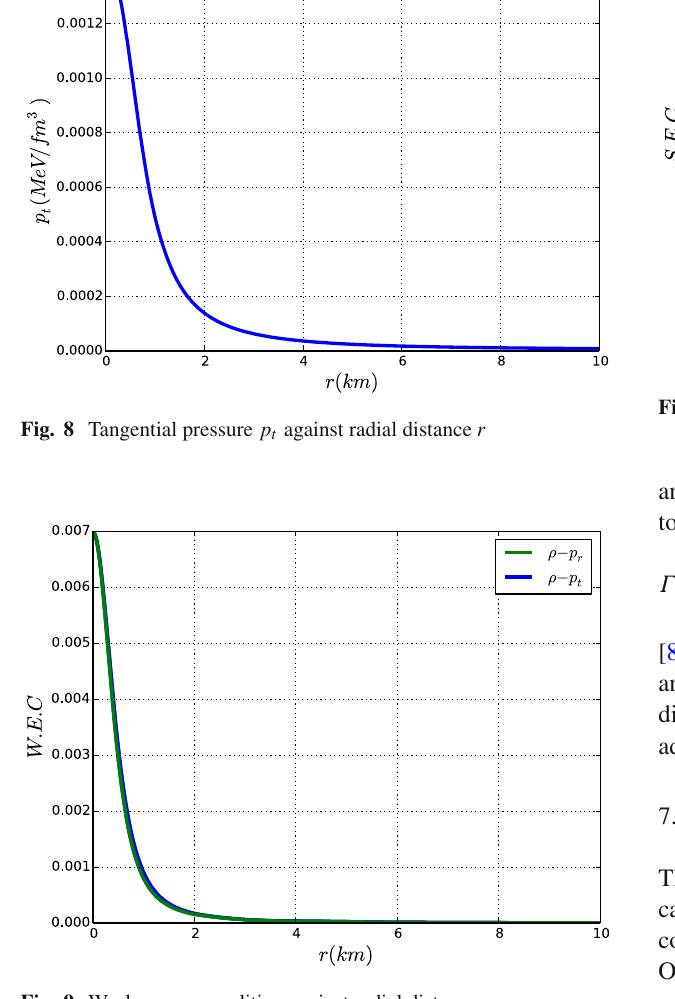
Fig. 9 Weak energy condition against radial distance r